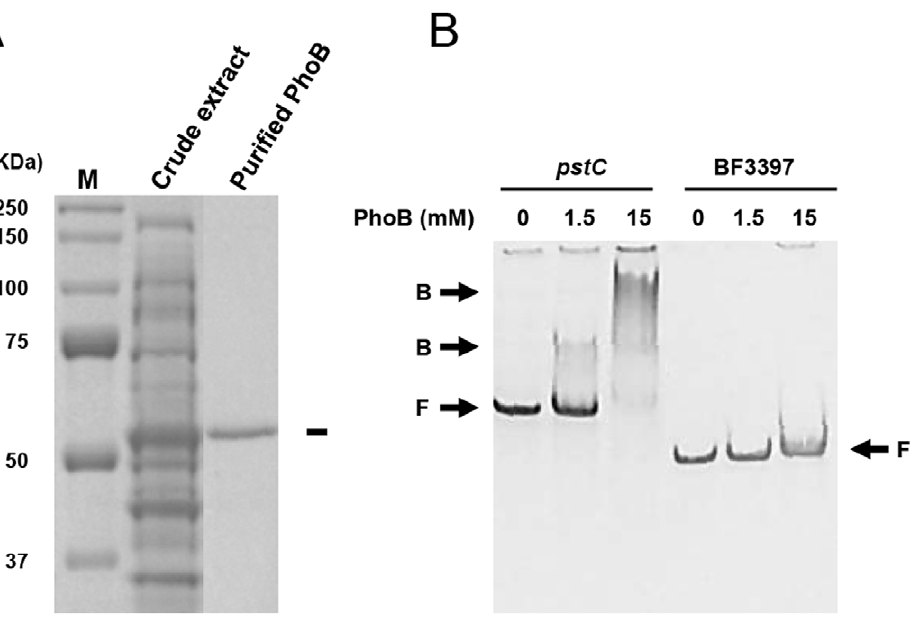
Figure 5. PhoB binds to pstC promoter. (A) Expression and purification of recombinant B. fragilis PhoB in E. coli . M, molecular size markers. (B) Binding of PhoB to pstC promoter. Recombinant PhoB (1.5 or 15 m M of final concentration) was mixed with the amplified promoter region of pstC or internal region of BF3397, and their interaction was evaluated by electrophoretic motility shift assay. Zero denotes that no protein was added to the reaction mixture. B: PhoB-bound probes; F: free probes.